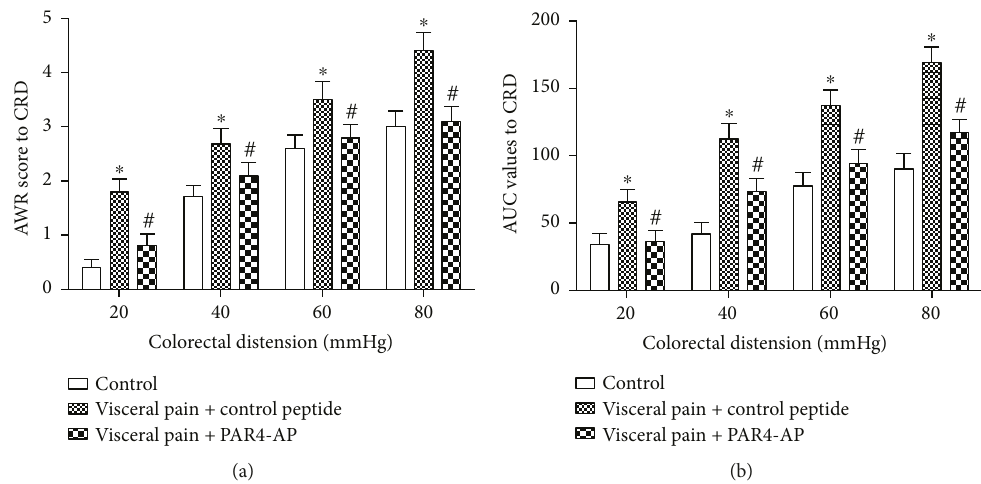
Figure 1: E ff ect of PAR4-AP on colorectal distension- (CRD-) induced visceral pain in the visceral hyperalgesia rats. (a) Abdominal withdrawal re fl ex (AWR) scores were used as an index of the response to CRD. (b) Area under the curve (AUC) of the electromyographic (EMG) activity in the external oblique muscle in response to CRD. All values are presented as the mean ± SEM ( n = 6 ). ∗ P < 0 05 versus control; # P < 0 05 versus control peptide